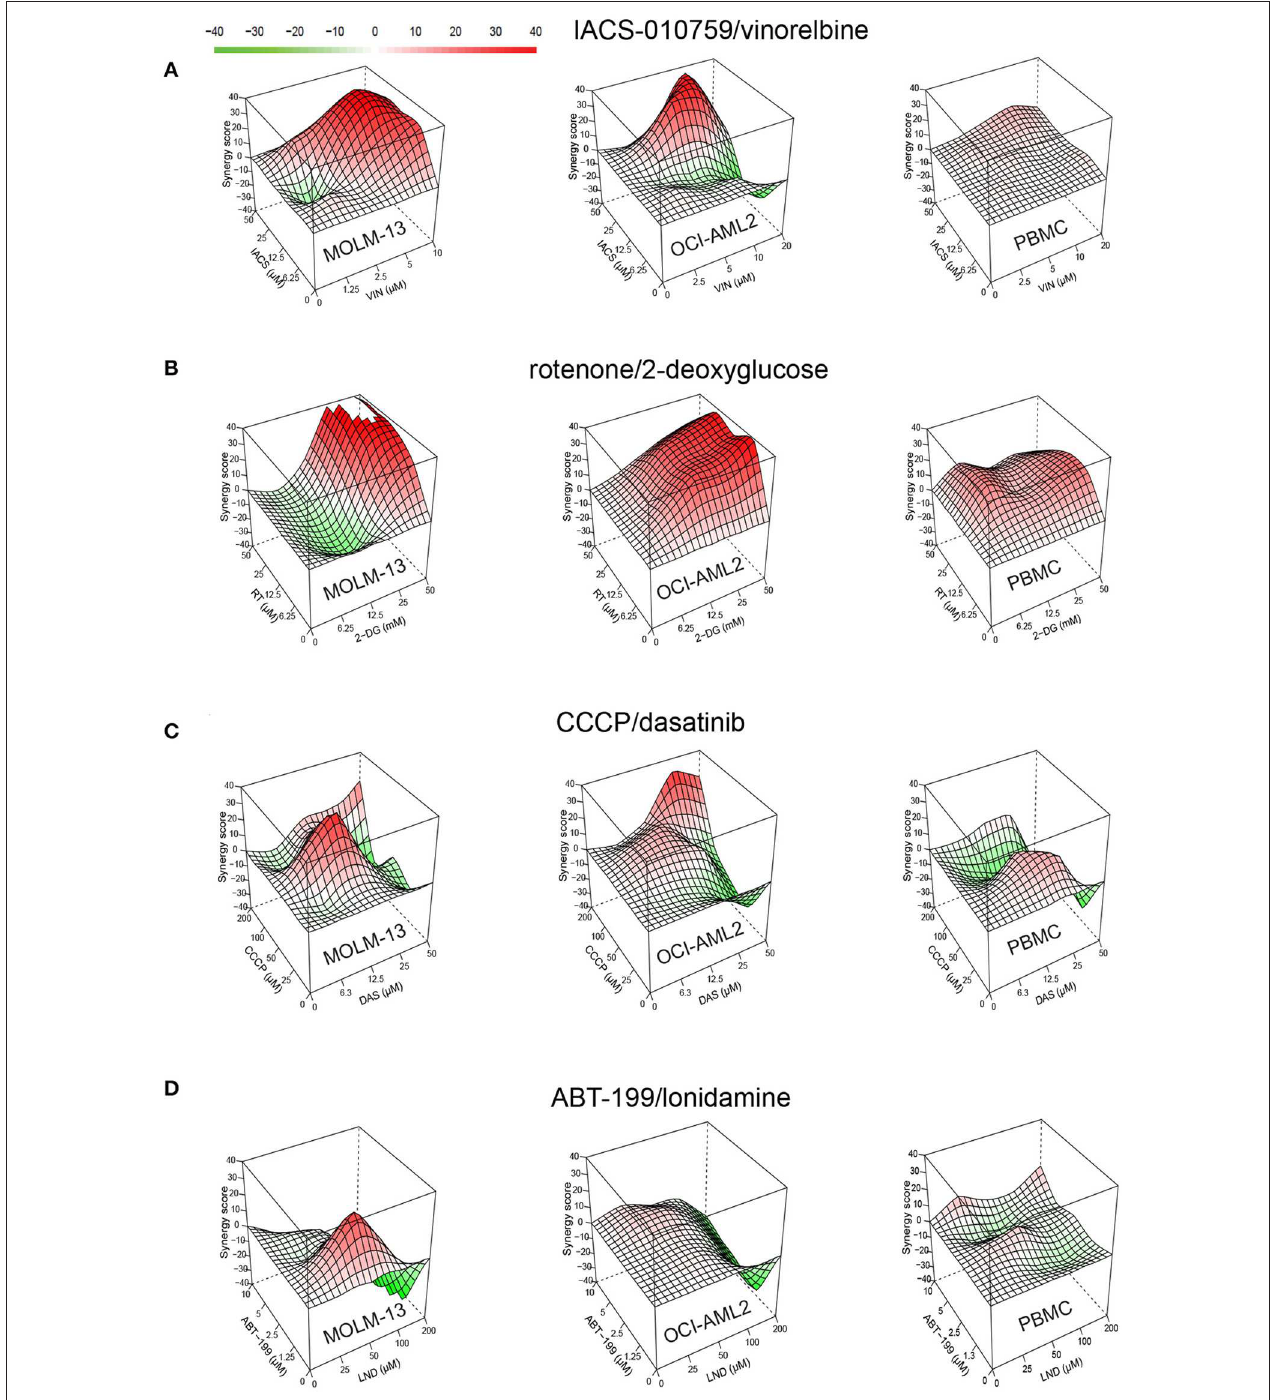
FIGURE 3 | Drug combinations demonstrate higher synergy in AML than in healthy cells. Synergy landscapes for MOLM-13, OCI-AML2, or healthy PBMCs after treatment with (A) IACS-010759/vinorelbine, (B) rotenone/2-deoxy-D-glucose, (C) CCCP/dasatinib, and (D) ABT-199/lonidamine. Drug combination landscapes: z-axis , synergy score (ranges from − 40 in green to + 40 in red); x/y-axes , drug1/drug2 concentration range, respectively. Drug combination landscapes were built using Bioconductor package “synergyfinder.” One representative replicate (with maximal synergy closest to the average value of three biological replicates) is shown.